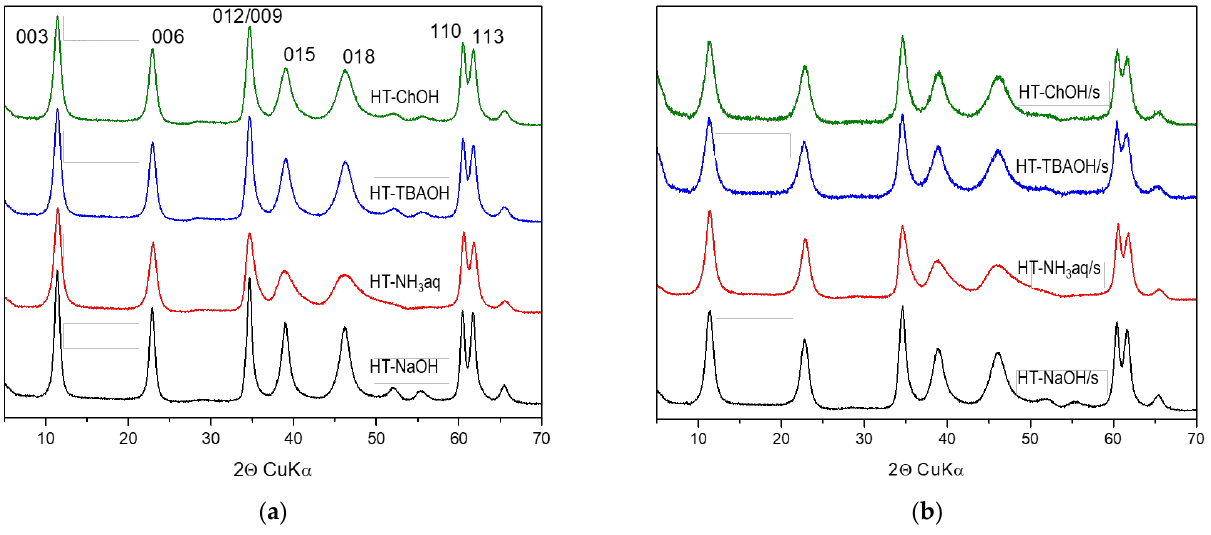
Figure 2. XRD patterns of HT materials obtained with the use of different precipitating bases: ( a ) synthesis in water ( b ) synthesis in aqueous starch solution. Table 1. Physico-chemical parameters of synthesized HT solids: interplanar d 003 and d 110 distances, crystal sizes in the c direction (D 003 ) and along ab plane (D 110 ), D 110 /D 003 aspect ratio, Mg/Al ratio, Na,